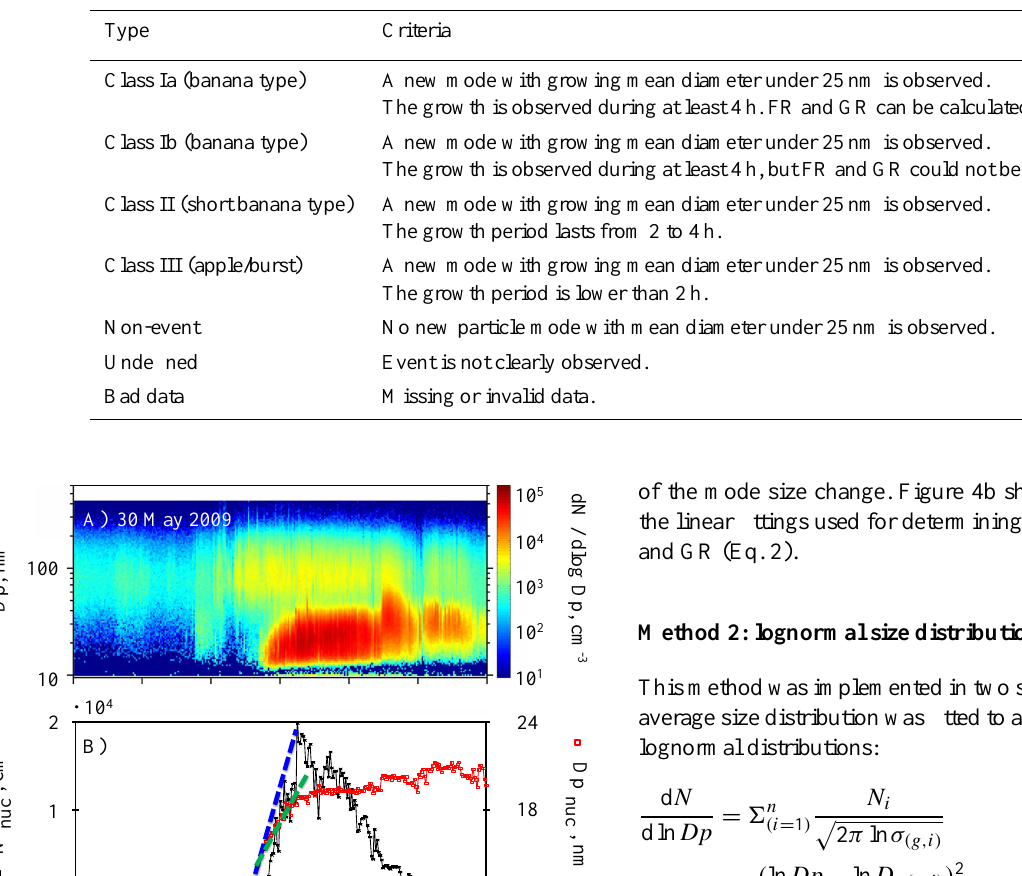
Table 1. Type of events considered in this study. FR: formation rate. GR: growth rate.